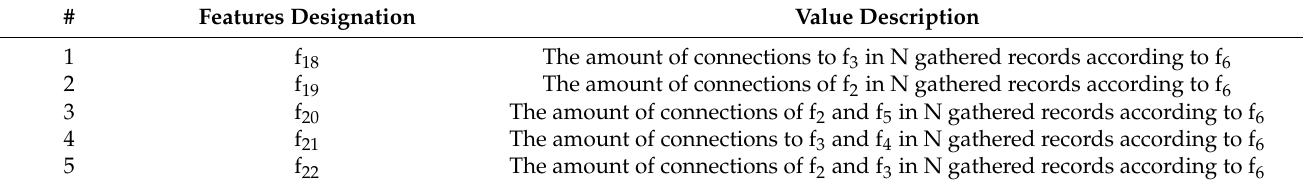
Table 3. MQTT-based features.